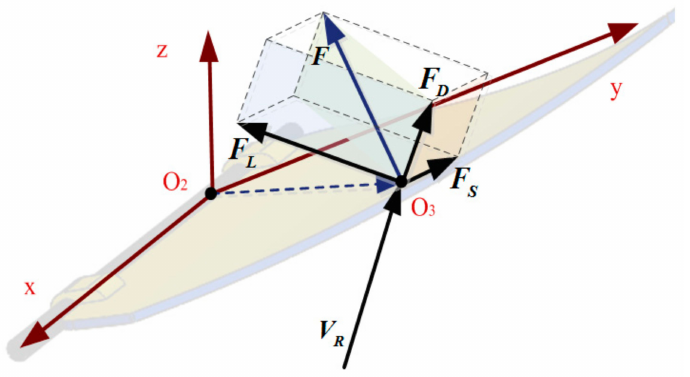
Figure 14. Dynamic characteristics of